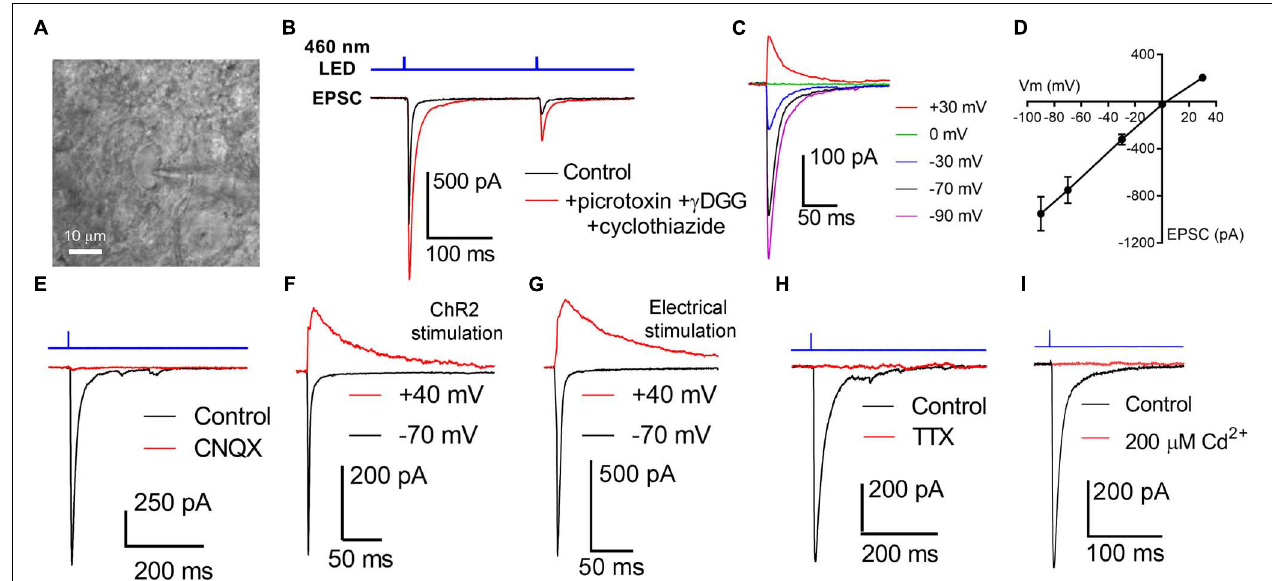
FIGURE 3 | Activation of channelrhodopsin in dLGN brain slices evokes post-synaptic responses in TC neurons. (A) Thalamocortical neurons were targeted for whole-cell patch-clamp recording in dLGN brain slices. (B) Stimulation with a pair of full strength flashes from the TLED (0.5 ms duration, 200 ms interval, 1.5 mW) evoked large currents displaying paired pulse depression. Current amplitude was enhanced and decay kinetics slowed by addition of 200 µ M γ DGG and 100 µ M cyclothiazide. Sixty mM picrotoxin was added to block inhibition. (C,D) In a current-voltage experiment, currents reversed near the cationic equilibrium potential ( ∼ 0 mV). (E) ChR2-evoked currents were sensitive to the AMPA receptor blocker CNQX, consistent with responses being excitatory post-synaptic currents (EPSC). (F) Slower, presumptive NMDA receptor-mediated EPSCs could be detected at depolarized potentials. (G) The AMPA/NMDA ratio was similar when the optic tract was stimulated using an extracellular electrode in parasagittal brain slices. (H) EPSCs were blocked by the Na + channel blocked Tetrodotoxin (1–2 µ M). (I) EPSCs were blocked by the Ca 2 + -channel blocked Cd 2 + (200 µ